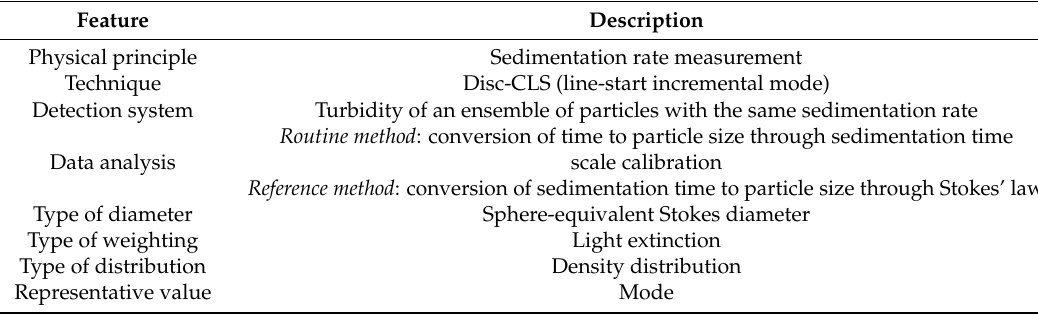
Table 3. Relevant features of the disc-CLS